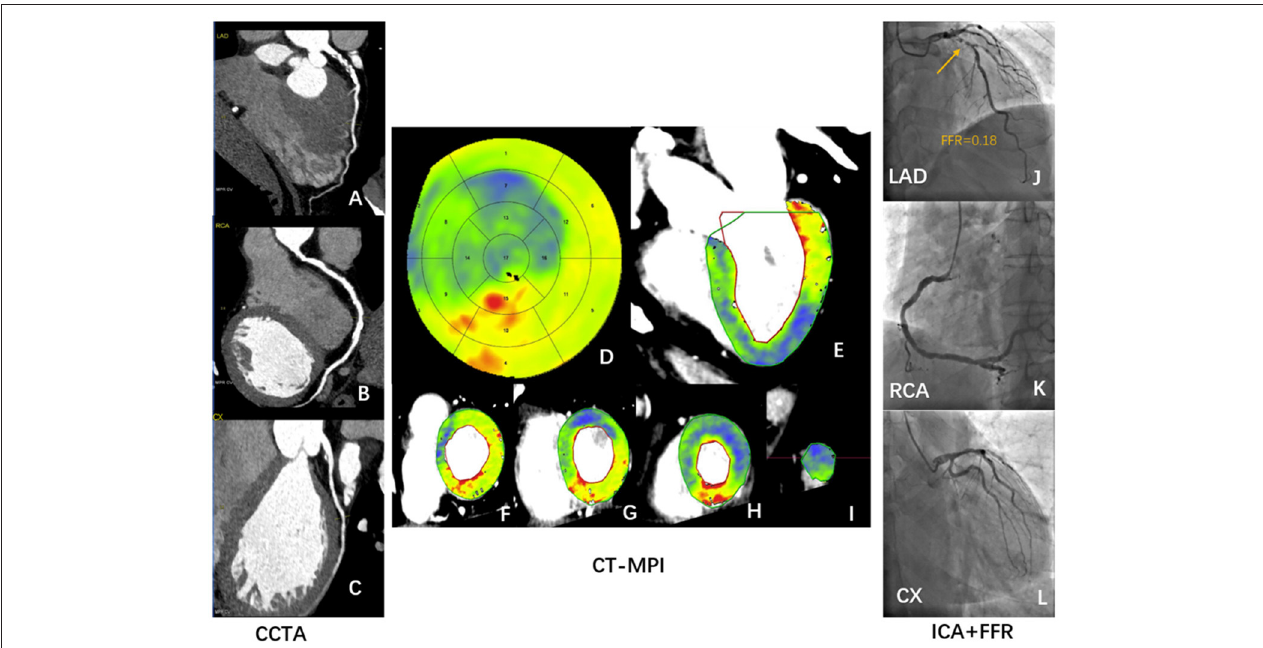
FIGURE 6 | Case illustrating hyperemic MBF can identify ischemic stenosis confirmed by ICA/FFR. A 56-year-old man who presented with a history of hypertension, current smoking, symptomatic for suspected angina, and a recent inconclusive 24 h’ DCG. (A–C) Rest CCTA shows severe stenosis of distal LAD (A) and multiple mild stenosis of RCA (B) . (D–I) Dynamic stress CT-MPI bull’s eye diagram (D) , long axis view (E) , and short axis view (F–I) all show severe induced perfusion defects in the anterior wall, septum, and apical wall of left ventricle. The regional hyperemic MBF of LAD, RCA, LCX are 77 ml/100 mml/min, 126 ml/100 ml/min, and 107 ml/100 ml/min, respectively. (J–L) ICA shows severe proximal LAD stenosis (J) with positive invasive FFR (J) . ICA shows multiple mild stenosis in RCA (K) and no stenosis of LCX (L) . CCTA, coronary computed tomography angiography; CT-MPI, computed tomography myocardial perfusion imaging; DCG, dynamic cardiogram; FFR, fractional flow reserve; ICA, invasive coronary angiography; LAD, left anterior descending coronary artery; LCX, left circumflex coronary artery; MBF, myocardial blood flow; RCA, right coronary